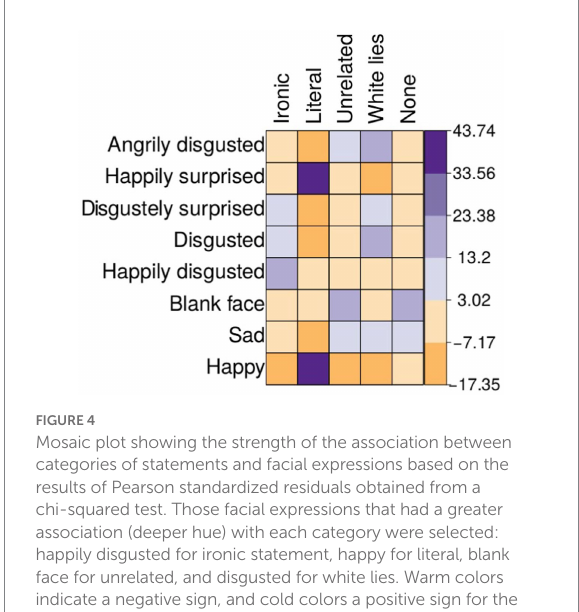
FIGURE 4 Mosaic plot showing the strength of the association between categories of statements and facial expressions based on the results of Pearson standardized residuals obtained from a chi-squared test. Those facial expressions that had a greater association (deeper hue) with each category were selected: happily disgusted for ironic statement, happy for literal, blank face for unrelated, and disgusted for white lies. Warm colors indicate a negative sign, and cold colors a positive sign for the